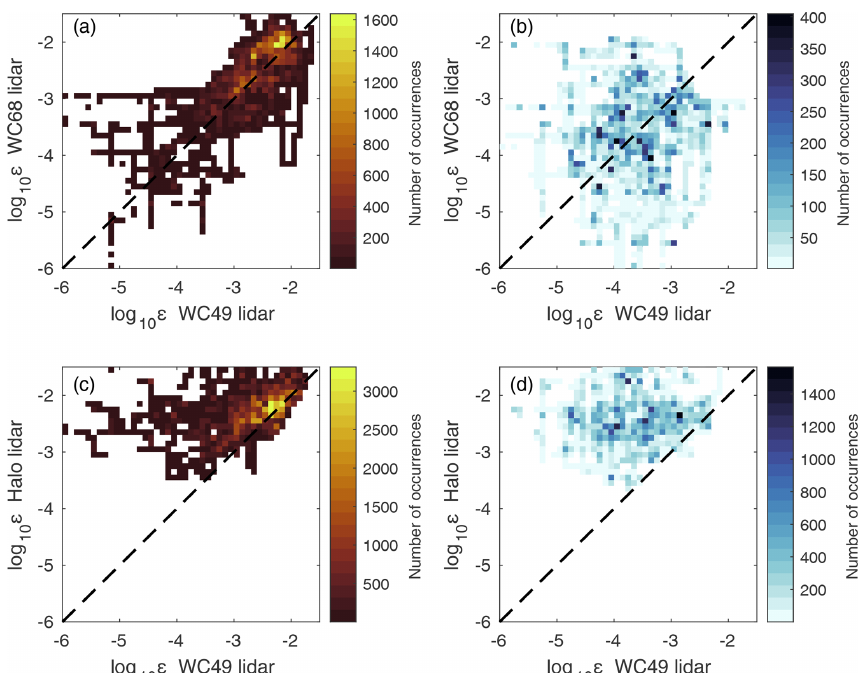
Figure 9. Heat map of log 10 ε estimated at 100m showing the spatial variability for both WindCube lidars (a, b) and the platform variability for the WindCube and Halo lidars (c, d) . The shading indicates the number of occurrences of each value of log 10 ε for each lidar; warm shading corresponds to daytime and cool shading to nighttime. The values of turbulence dissipation rate are averaged over a 30min time period. The black dashed line shows a 1 : 1